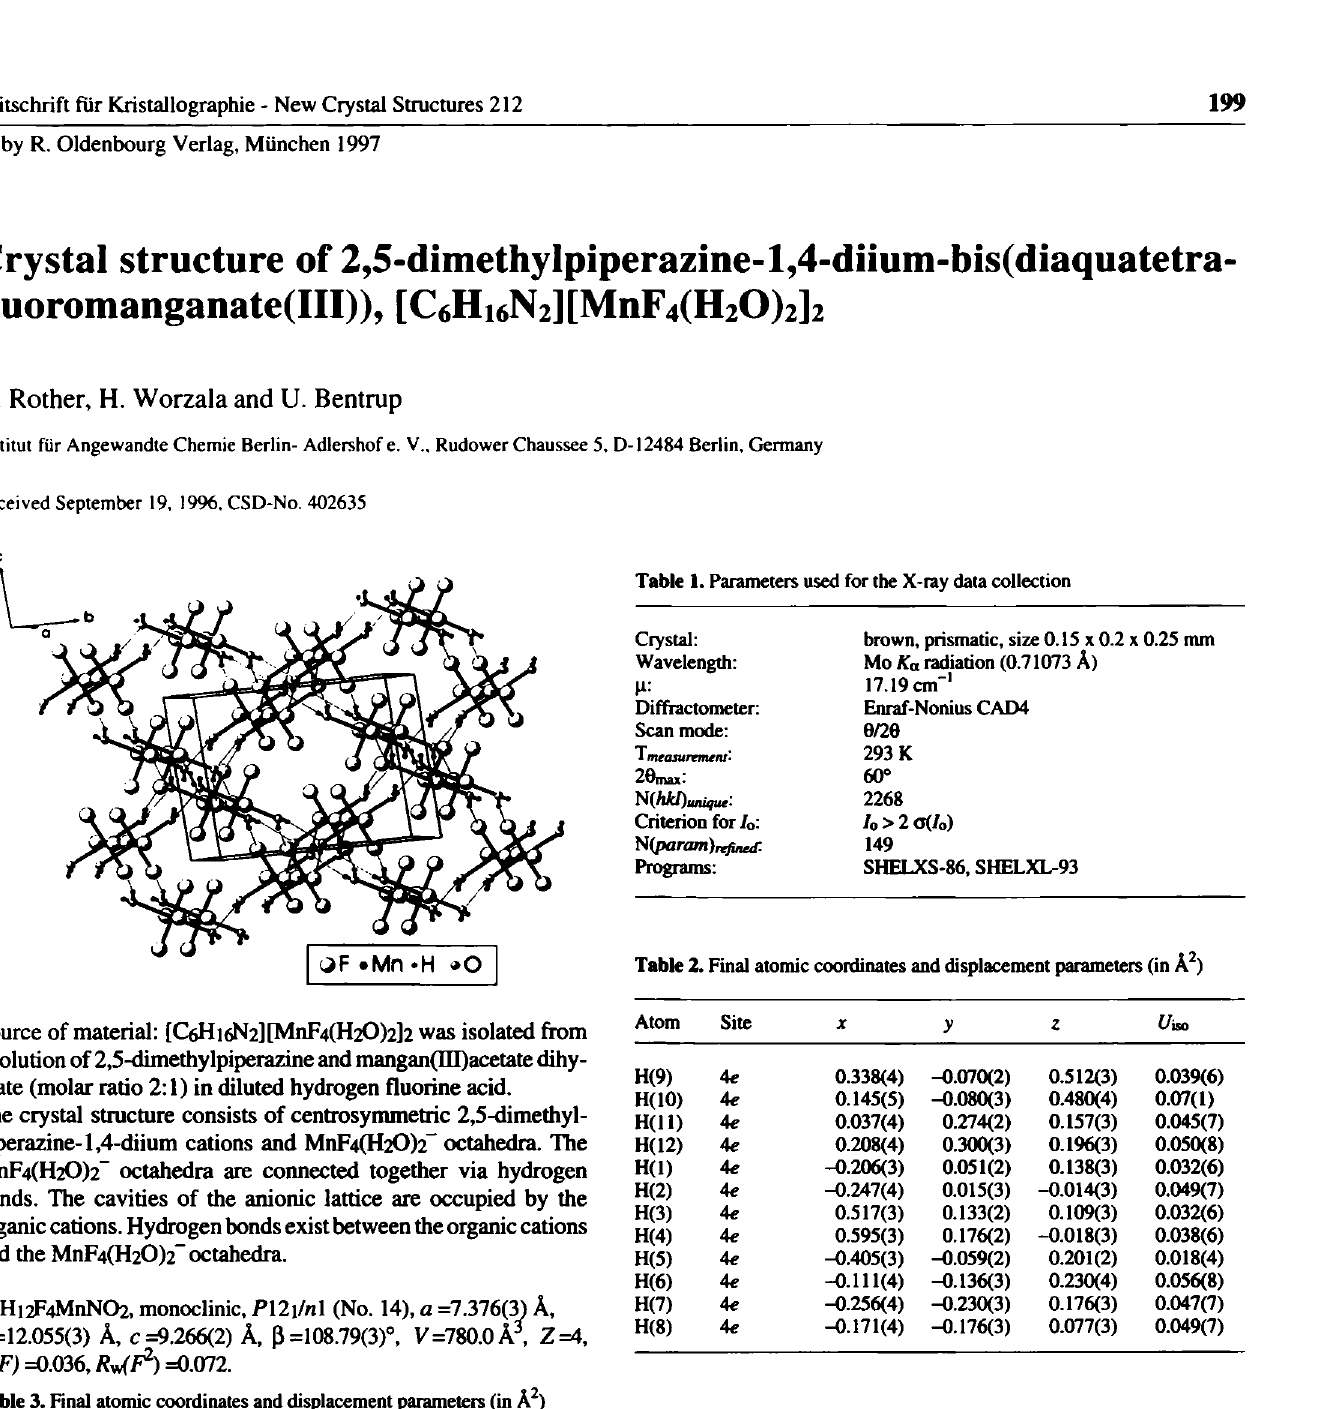
Table 3. Final atomic coordinates and displacement parameters (in Â 2 )